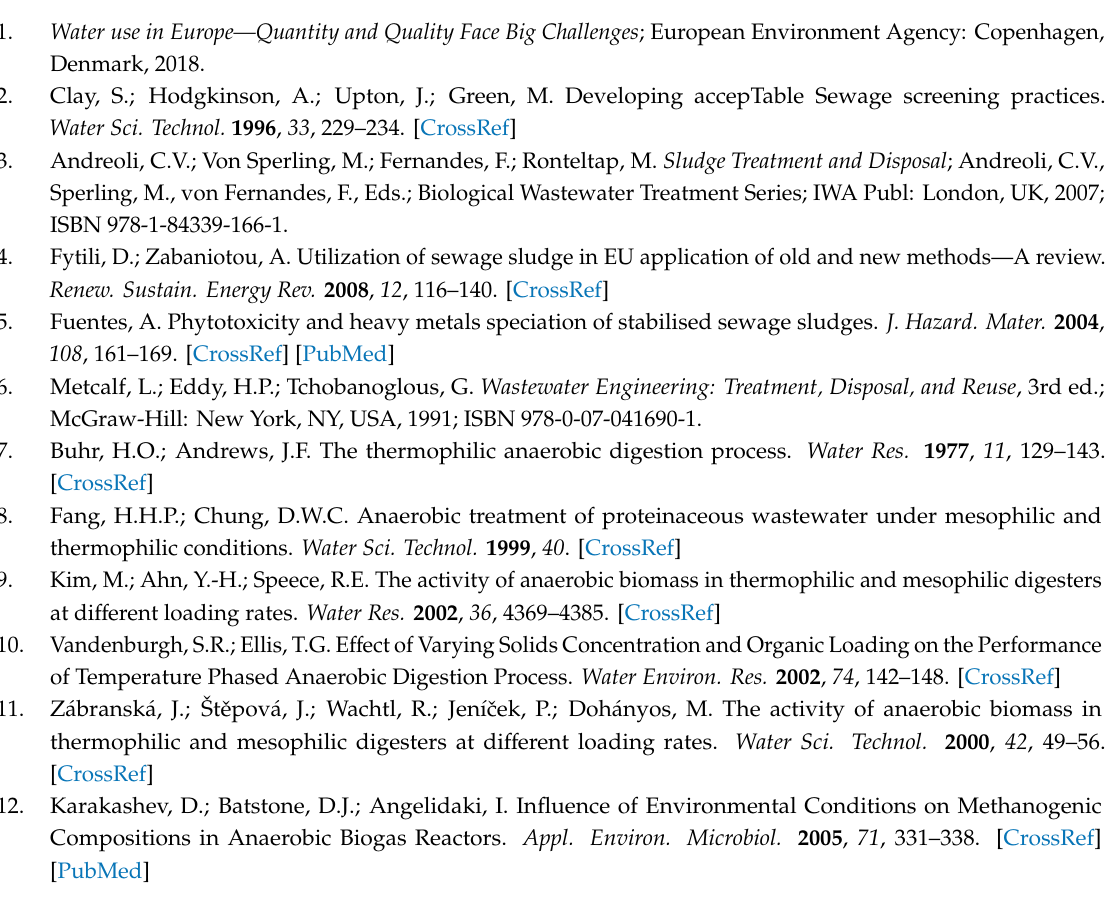
Table S1: Sewage sludge characteristic at 1st and 18th sampling day in di ff erent temperature in the fermenter, Table S2: Methane concentration (a), hydrogen concentration (b) and hydrogen sulfide concentration (c) at di ff erent temperatures 1st and 18th day of fermentation, Tukey test (P < 0.05), Table S3: Amplicon sequence variants table of all methanogenic archaea detected in fermenters classified down to species